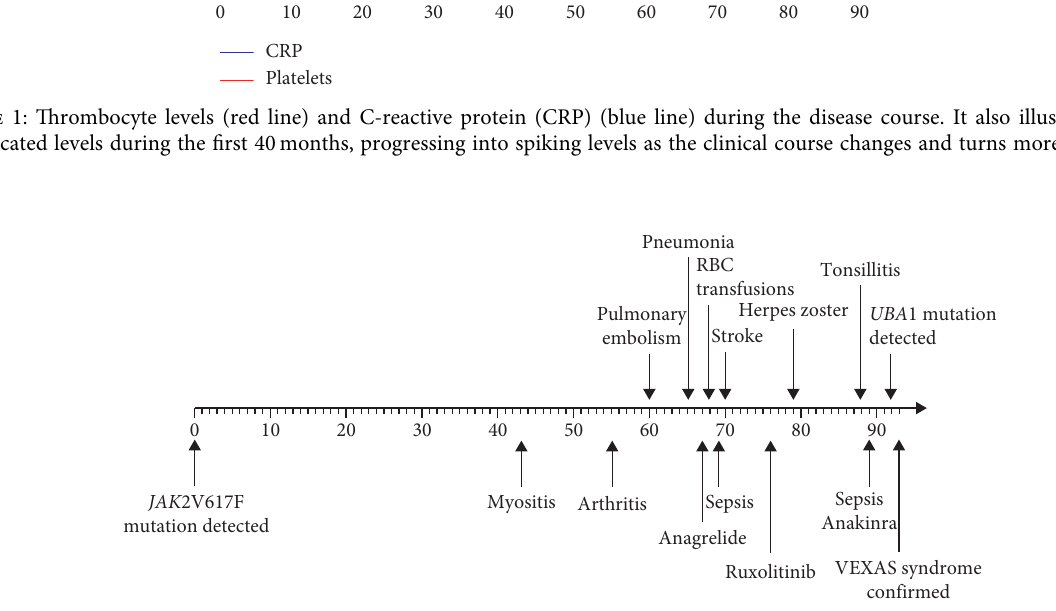
Figure 2: Timeline in months showing the most signifcant events of his disease progress from time of the ET diagnoses until the complicated course of VEXAS syndrome. RBC: red blood